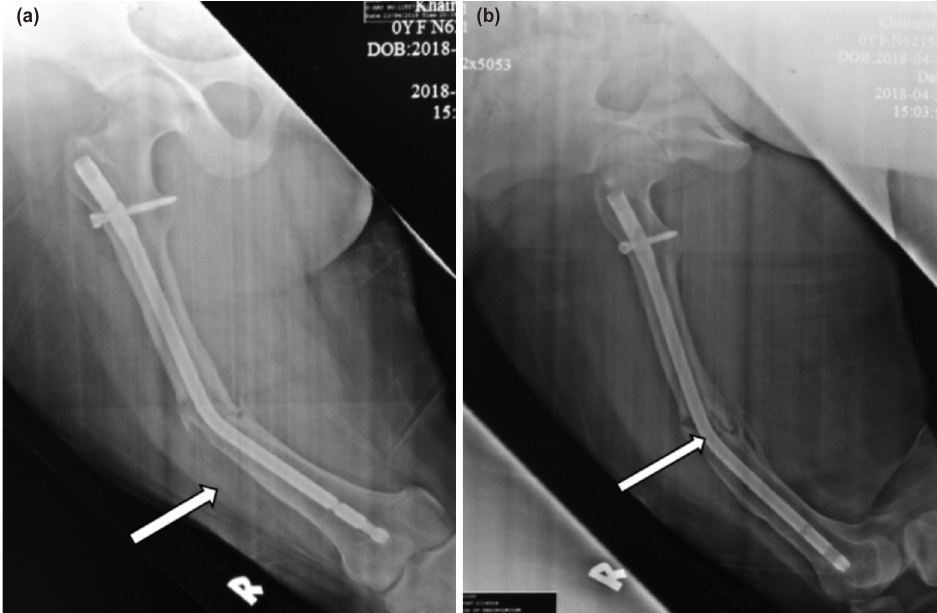
(a) Plain radiograph shown 30° varus angulation of femoral nail in AP view (b) and 30° anterior angulations in lateral view with Fig. 1: the continuity of the nail was intact. It also shown that the femoral shaft fracture was not united with unicortical callus formation.